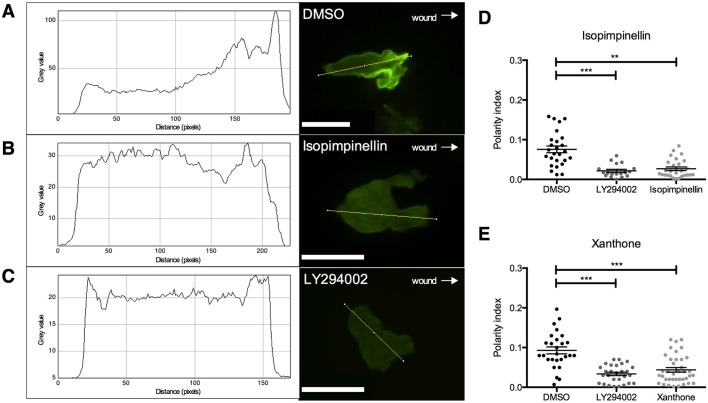
Isopimpinellin and xanthone inhibit polarisation of neutrophils upstream of PI3K. Assay to measure the polarity index of neutrophils in Tg(lyz:PHAkt-EGFP) larvae pretreated with 25 μM isopimpinellin, 25 μM xanthone, 50 μM LY294002 or DMSO as a vehicle control for 2 h prior to tail-fin injury. Representative images of individual neutrophils in the region between the wound site and posterior blood island illustrate polarisation and a defined leading edge of a migrating neutrophil in (A) DMSO control-treated larvae, compared to (B) isopimpinellin- and (C) LY294002-treated larvae, which do not polarise or have a defined leading edge (scale bars: 11 μm). Arrows indicate direction of wound. Fluorescence (referred to as grey value) was measured in a transection of each neutrophil (the yellow lines drawn through the cells) to generate intensity profiles shown in the panels on the left and quantify neutrophil polarity index as previously described (Wang et al., 2014). Both (D) isopimpinellin and (E) xanthone reduced the neutrophil polarity index to a similar level as the known PI3K inhibitor LY294002 (one-way ANOVA with Dunnett's multiple-comparison post-test; **P<0.01, ***P<0.001; n=27, performed as three independent experiments).